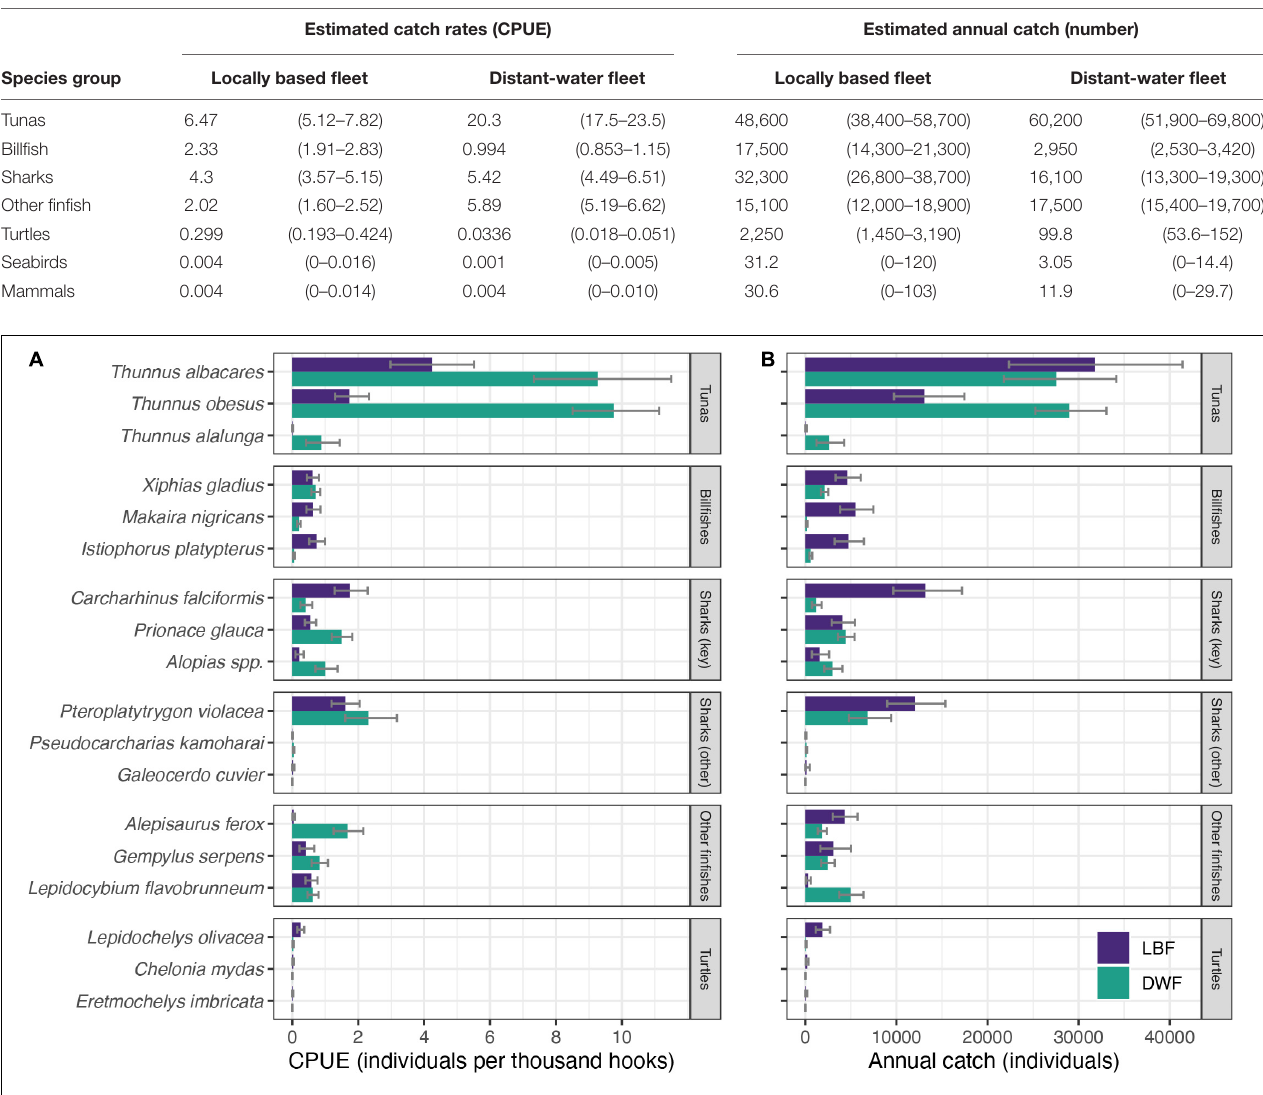
FIGURE 4 | Estimated (A) catch rates (individuals per thousand hooks) and (B) mean annual catch (individuals) of selected species for the LBF (purple) and the DWF (green), based on observer data collected from 2007 to 2019. Error bars represent 95% confidence intervals